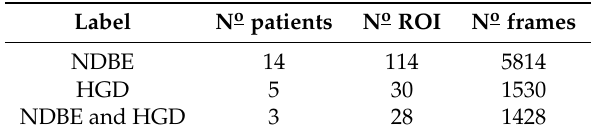
Table 1. Class distribution based on the regions of interest (ROIs) of the training dataset of the first 22